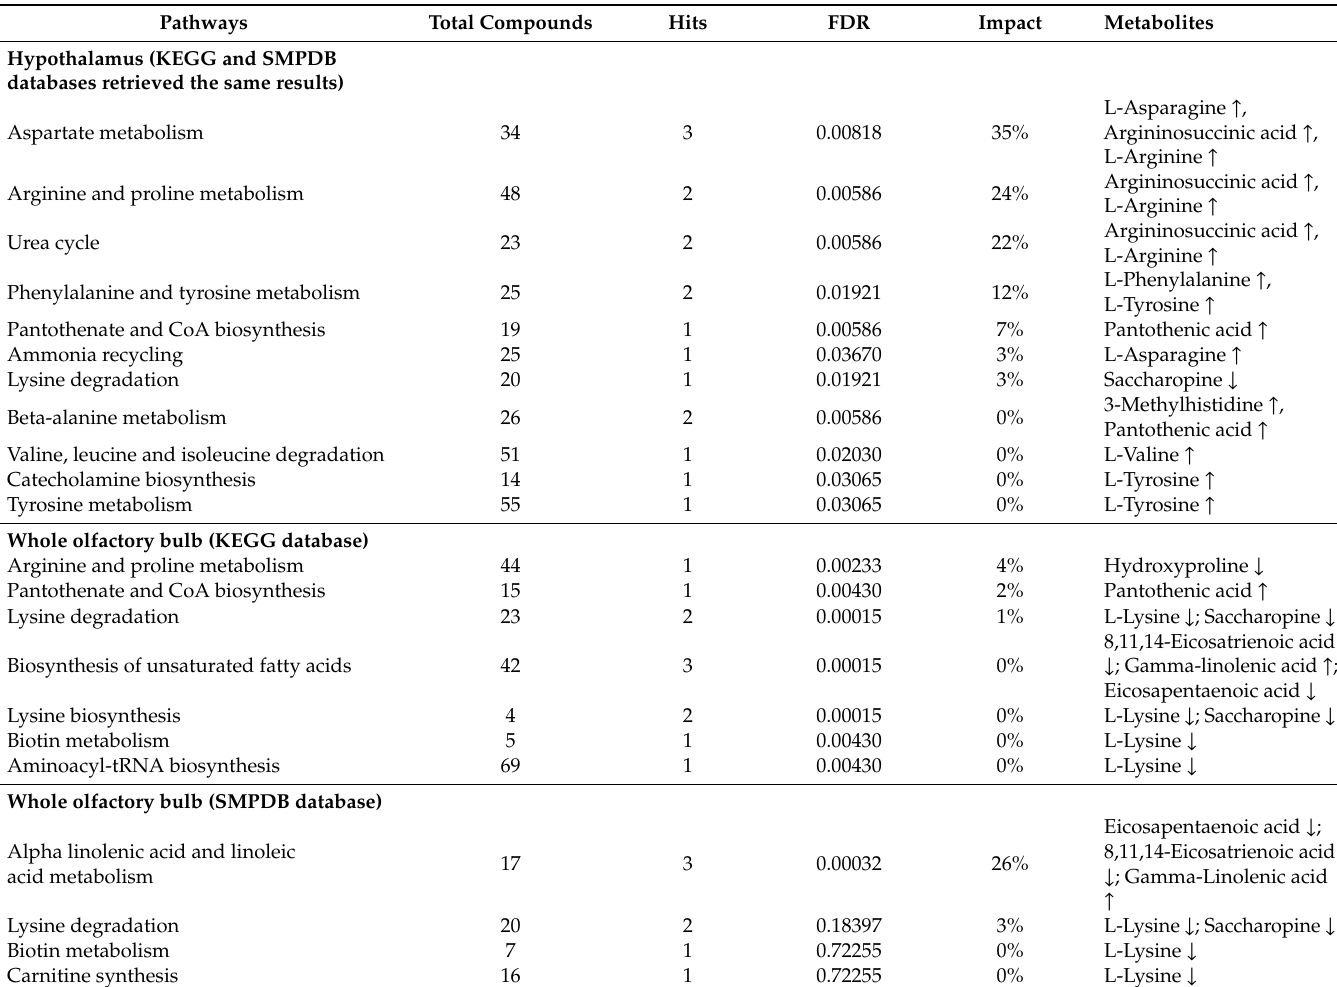
Table 3. Pathway (KEGG and SMPDB) enrichment analysis in the hypothalamus and whole olfactory bulb: comparison between males fed an HFD and males fed a